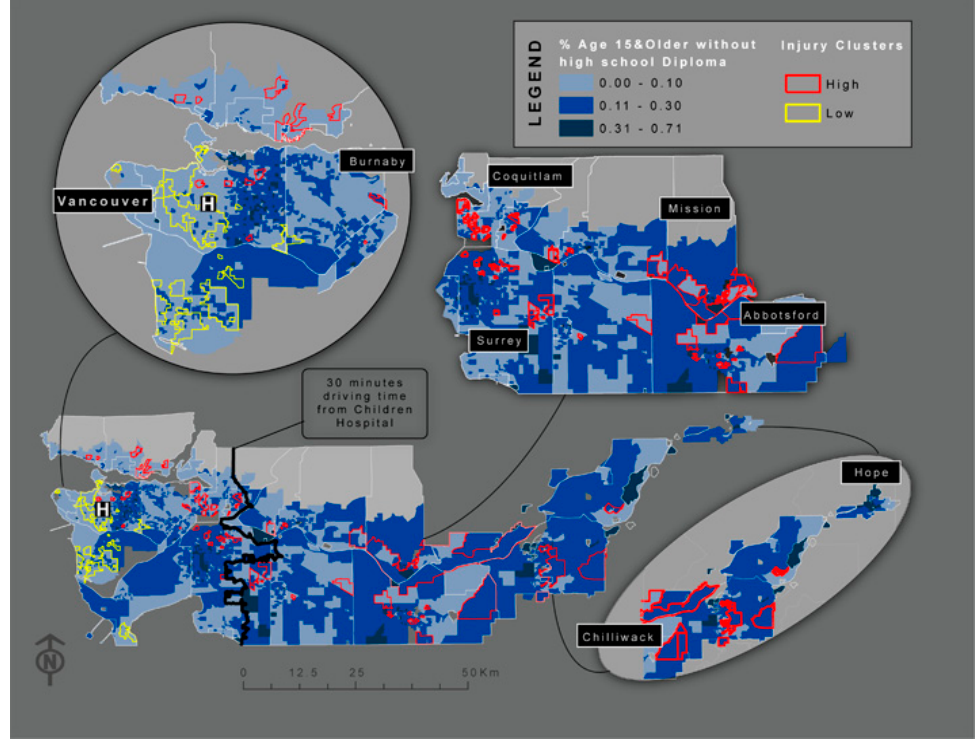
Figure 2. Dissemination Area (DA) level map indicating high (red) and low (yellow) clusters of TBI rates, overlapped with the percent of people age 15 and older with a high school diploma. There is a clear trend between TBI rate and possession of a high school diploma, with the highest rates of TBI occurring in areas where a very high proportion of the population did not obtain a high school diploma.